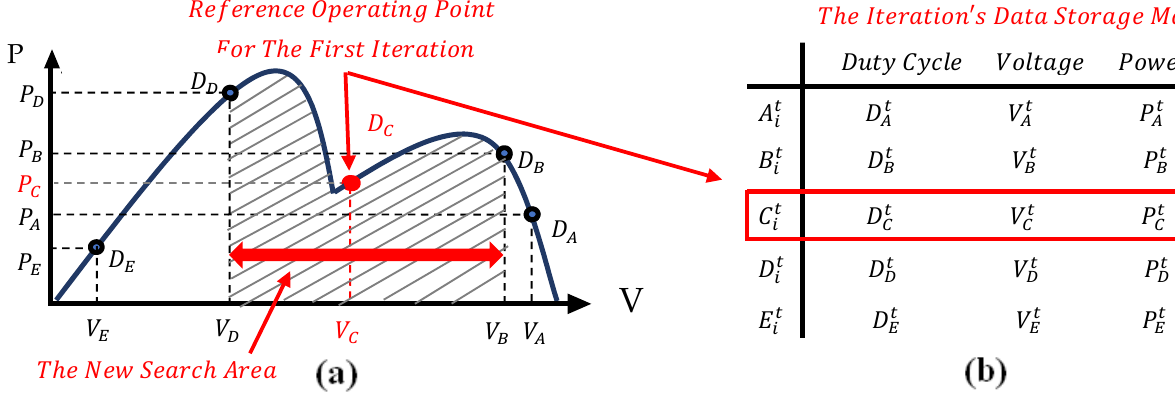
The left side from the reference power value